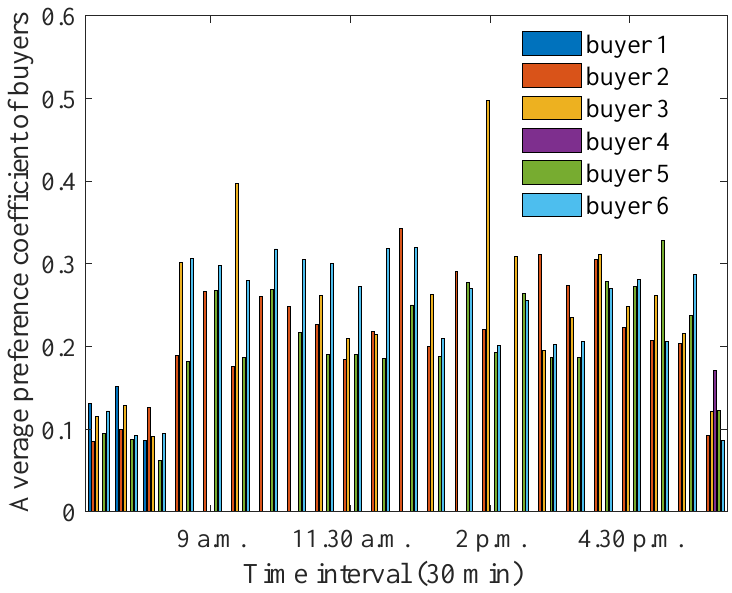
Figure 6. Optimum preference coefficients for buyers during winter